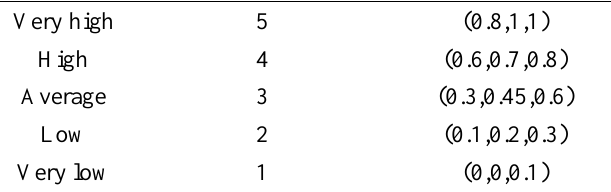
Table1. Fuzzy values of linguistic variable